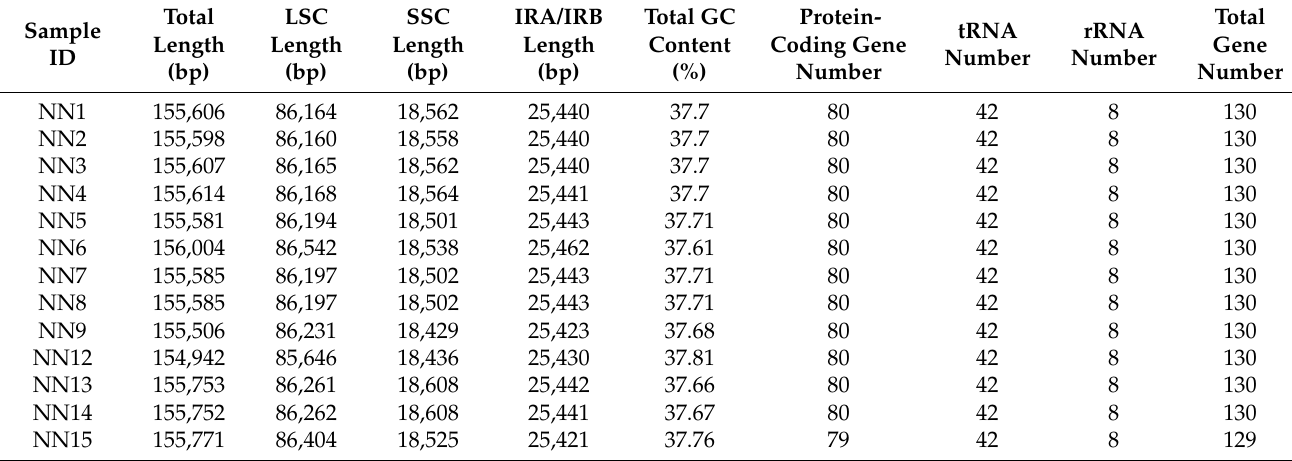
Table 3. Information on 13 cp gene annotation.